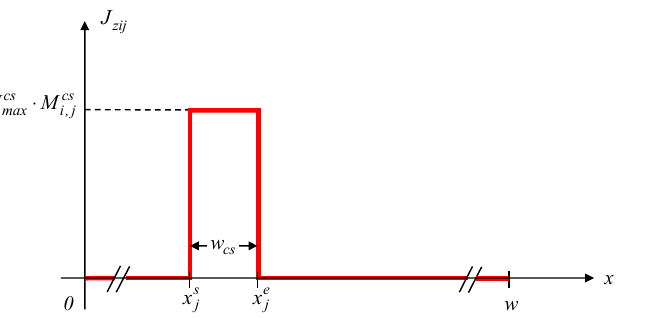
( ) i,j . Figure 2. Waveform of the spatial distribution of J zij in any conductive segments ( i , j ) .